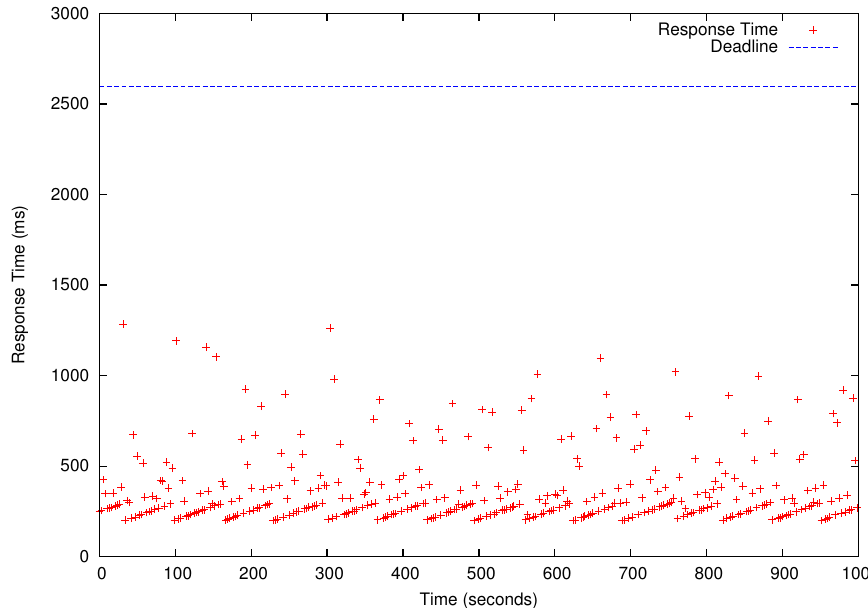
Figure 8. Response Times of Histogram (HG) Jobs. The blue horizontal bar is the deadline (2.6 s). Each red dot represents the response time of one periodic HG job.